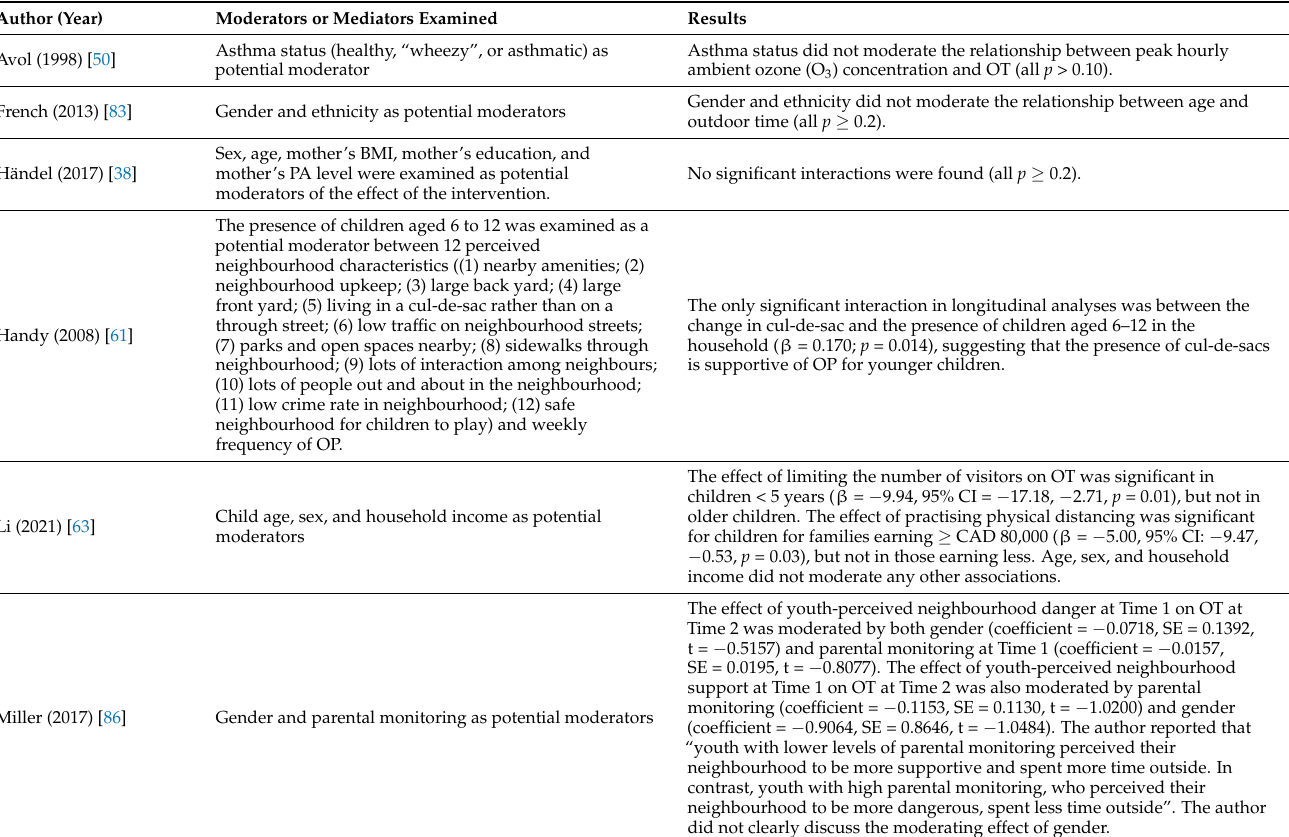
Table 4. Moderators and mediators examined in relation to outdoor